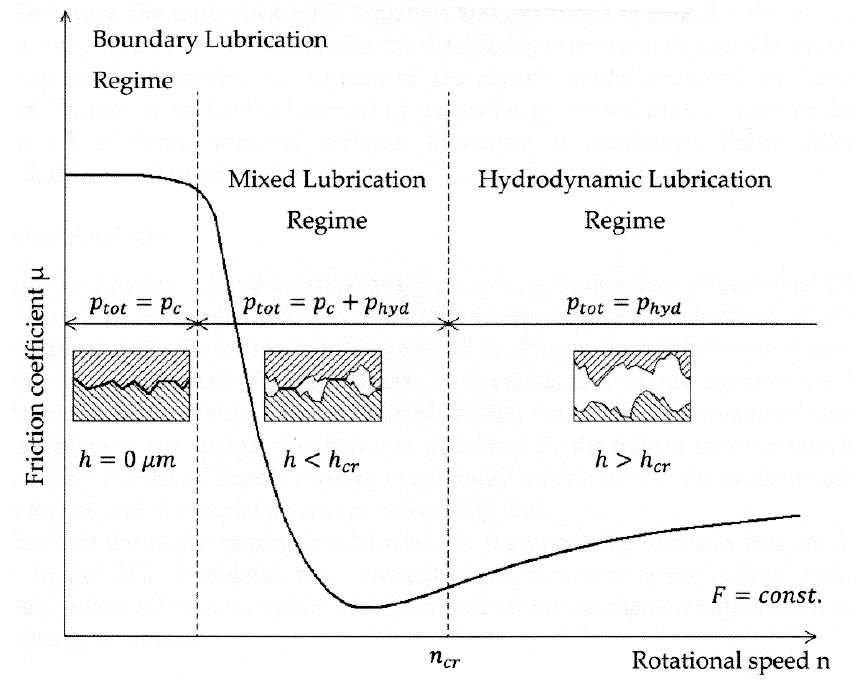
Figure 1 : Stribeck curve with different lubrication regimes (after Prölß et al.